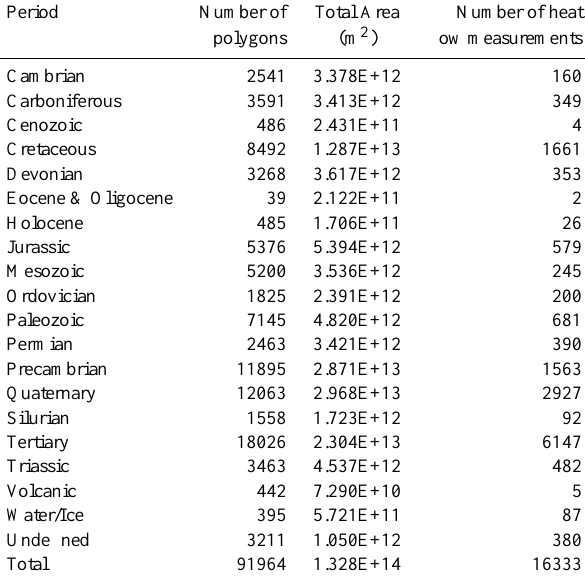
Table 2. Breakdown of the geology in Hearn et al. (2003), Global GIS (abbreviated as GG in the text).